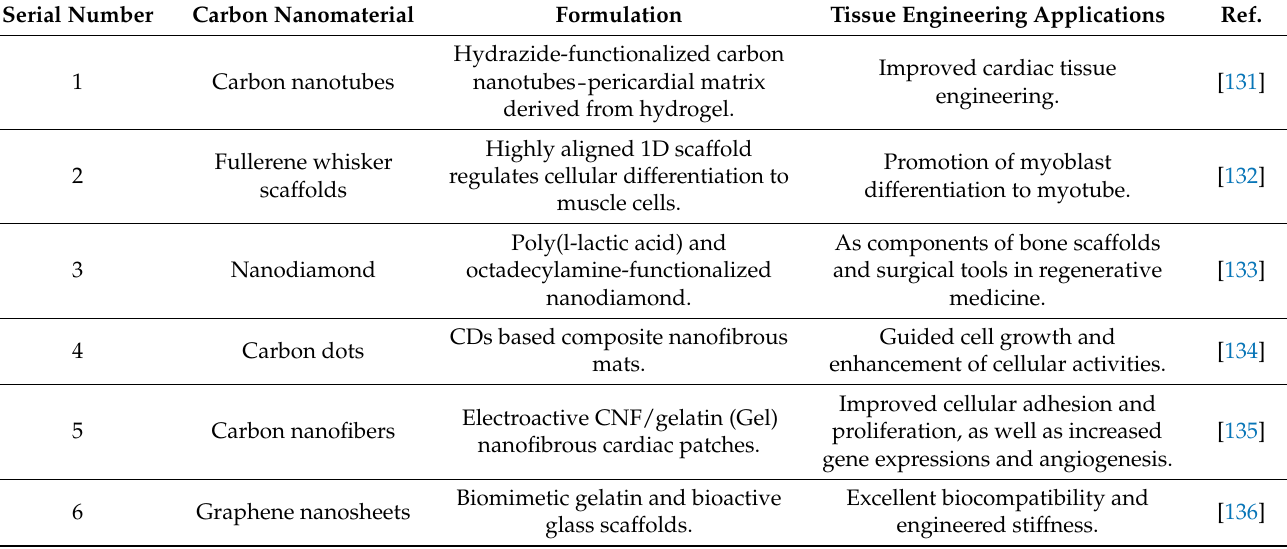
Table 4. Different uses of CNMs in tissue engineering